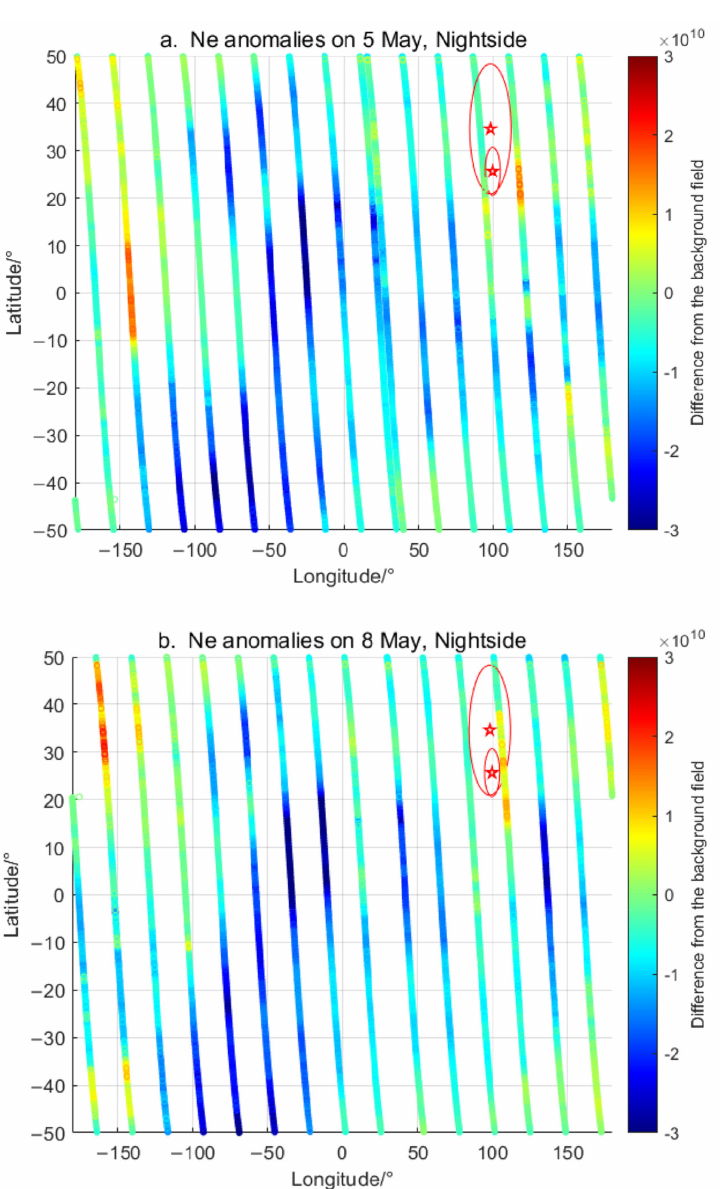
Figure 6. Ne anomaly after removing background field. The subfigure ( a , b ) represent the results of neightside on 5 May and 8 May, respectively. In each subfigures ( a , b ), the red stars and circles are epicenters and the seismogenic zones, the lower red star is Yangbi, and the upper one is Maduo. The color bar indicates the difference from the background field, with the unit in m − 3